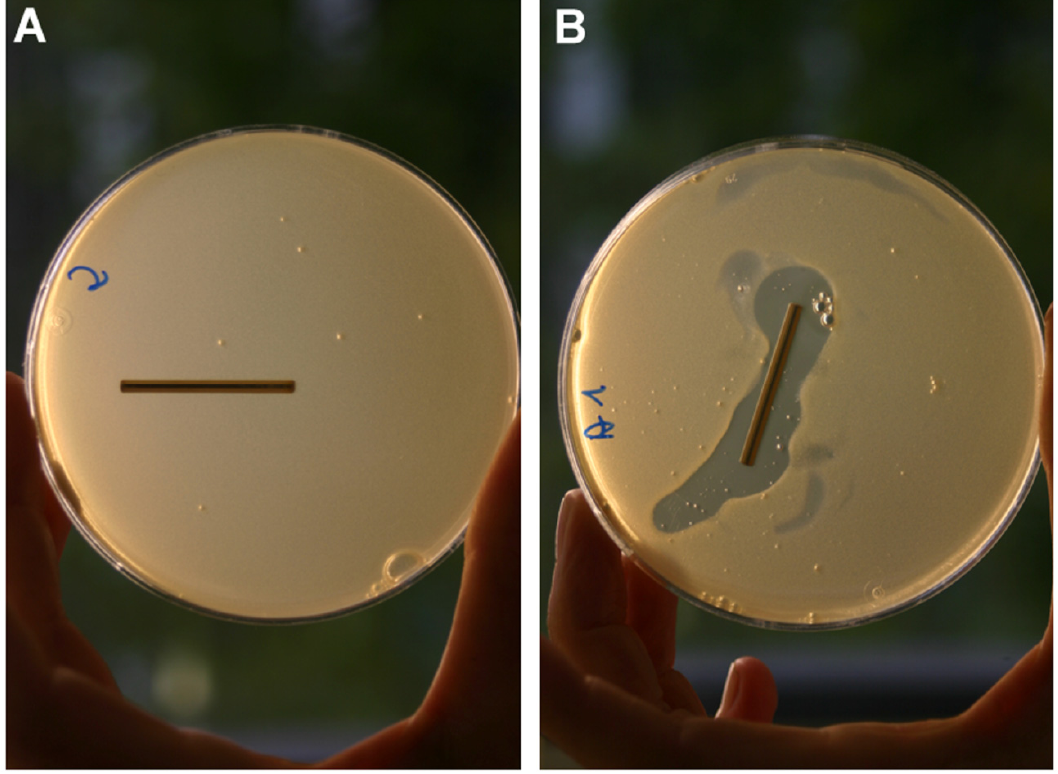
Figure 3. HBD-2-coated Kirschner-wire used for fracture fixation shows antimicrobial activity against Gram-negative bacteria. The wire was coated with poly-DL-lactide (PDLLA) ( A ) or PDLLA and HBD-2 (3 μ g) ( B ), and the antibacterial activity against the Gram-negative bacterium Pseudomonas aeruginosa was tested using agar diffusion